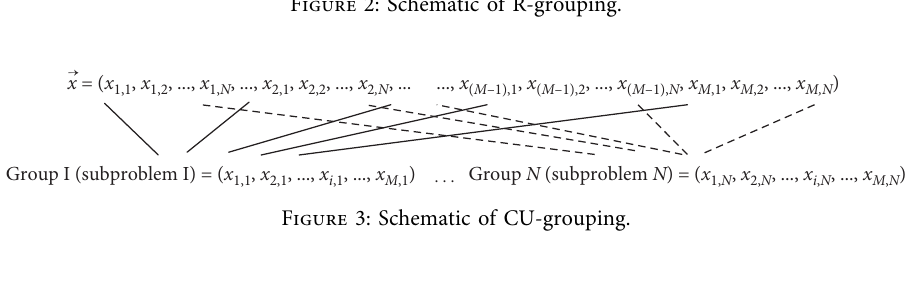
Figure 2: Schematic of R-grouping.